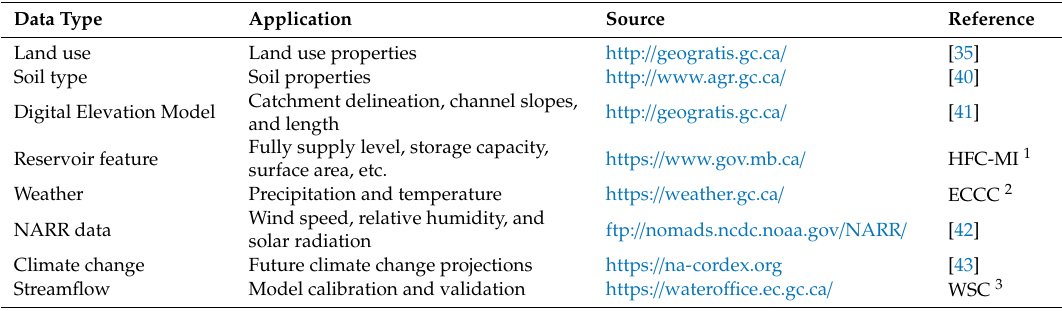
Table 1. Input data sources and description used to configure the soil water assessment tool (SWAT)